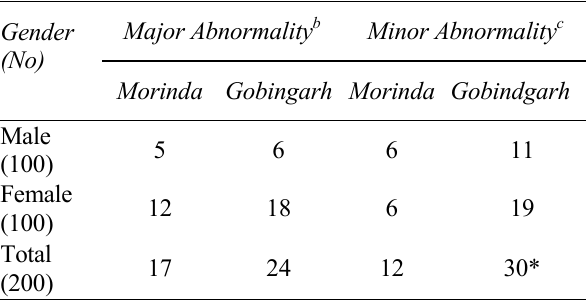
Table 9(a) : Prevalence of major and minor abnormality a in the population of the two study sites.